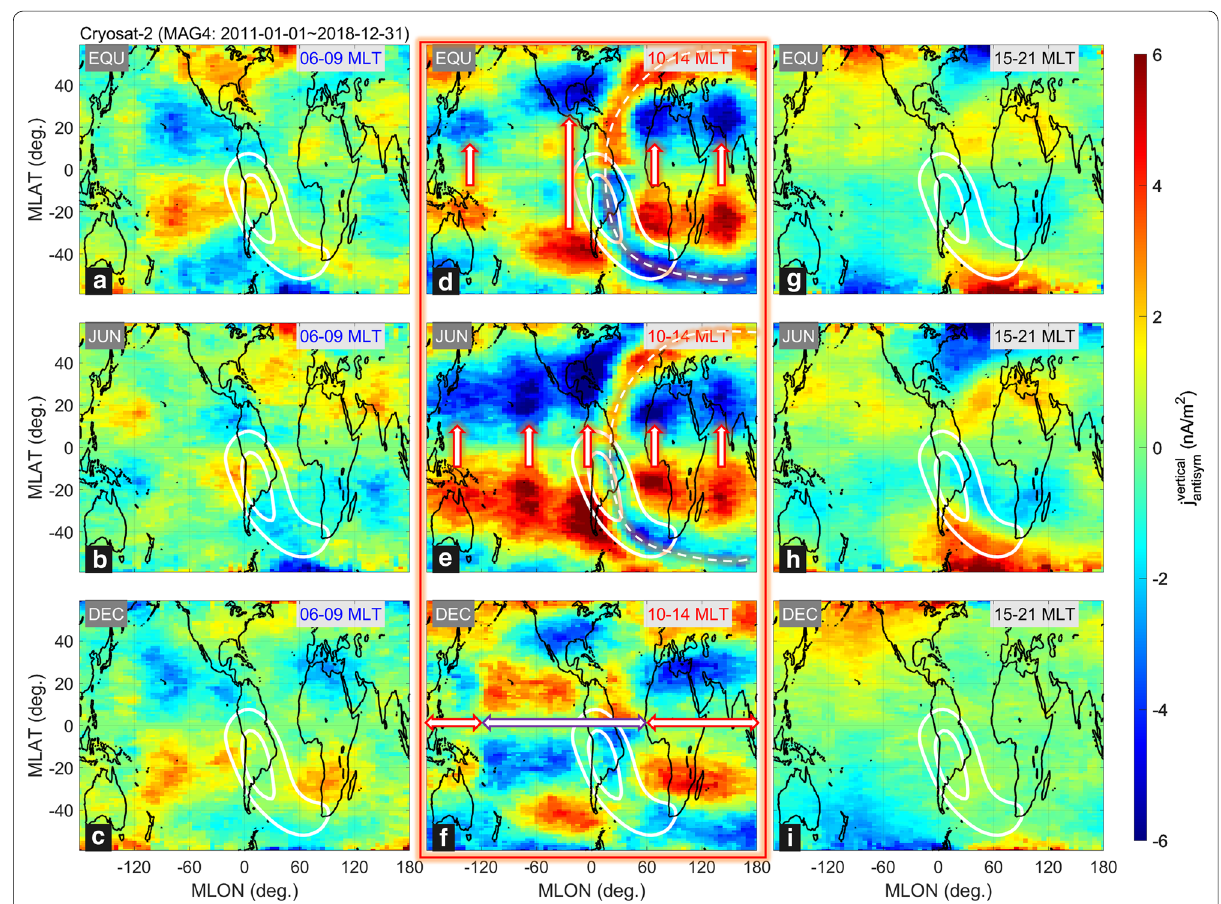
Fig. 8 Geographic distributions of IHFACs estimated from CryoSat-2 data. Each row from the top corresponds to a season: combined equinoxes, June solstice, and December solstice. Three columns from left to right are dawn (06–09 MLT), noon (10–14 MLT), and dusk (15–21 MLT),